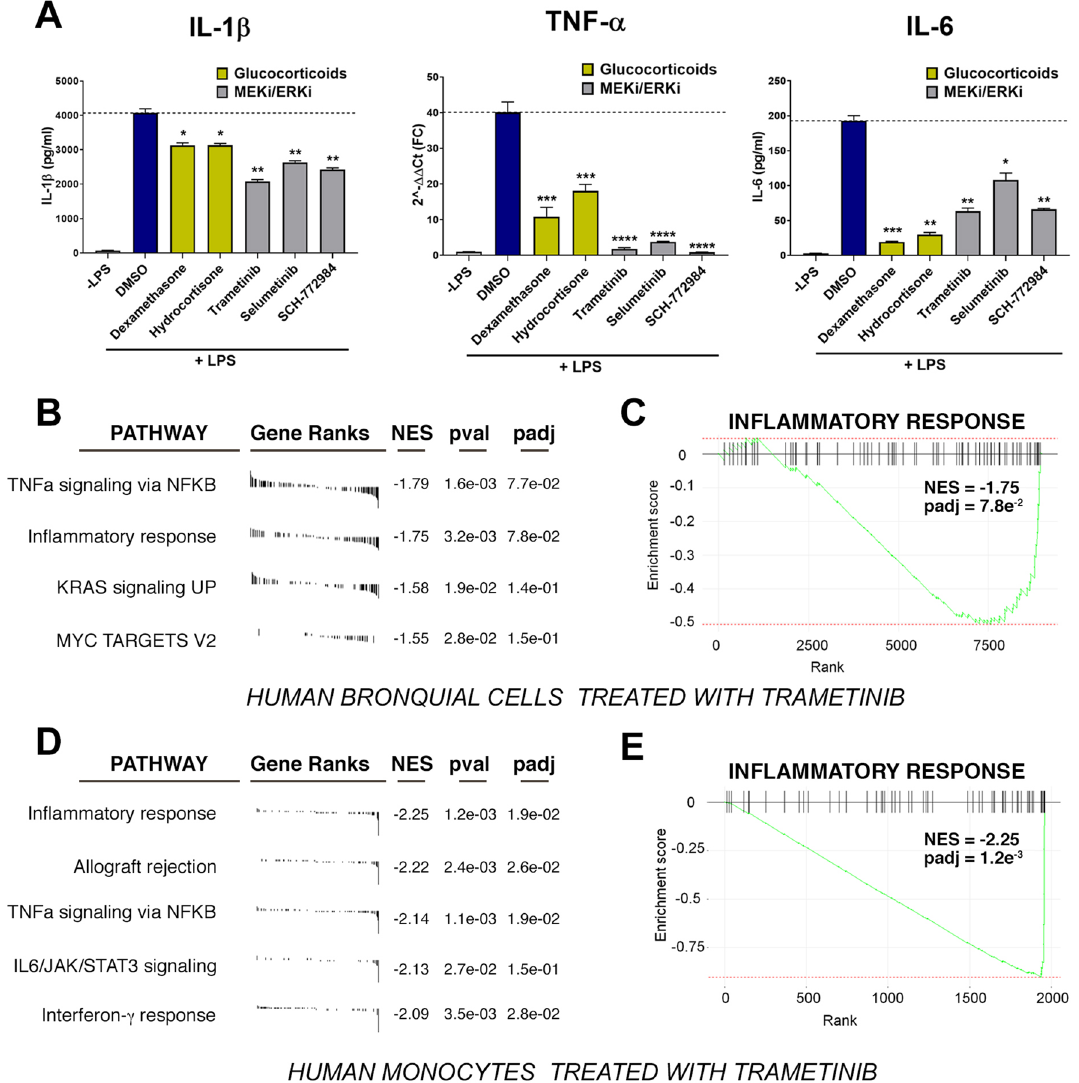
Figure 3. Inhibition of cytokine production by MEK and ERK inhibitors. ( A ) Cytokine expression in macrophages differentiated from THP1 cells upon exposure to LPS, with or without glucocorticoids (dexamethasone and hydrocortisone), MEK inhibitors (trametinib and selumetinib) and an ERK inhibitor (SCH-772984). IL-6 and IL-1β levels were measured by ELISA (pg/ml), and TNF-α by qPCR (2 −ΔΔCt (FC)). The experiment was repeated three times and a representative example is shown. *p < 0.05, **p < 0.01, ***p < 0.001, ****p < 0.0001 ( t test). ( B ) GSEA analysis from human bronquial cells treated with trametinib or DMSO as a control. Differential expression analyses were done from data publicly available at GEO (GSE63229). Pathways names together with their gene ranks, Normalized Enrichment Scores (NES), p-values (pval) and adjusted p-values (padj) are shown. ( C ) Enrichment plot of genes belonging to the “Inflammatory response” pathway resulting from the GSEA analysis mentioned in ( B ) illustrating the inhibition of their expression levels by trametinib in human bronchial cells. ( D ) GSEA analysis from human monocytes treated with trametinib or DMSO as a control. Differential expression analyses were done from data publicly available at GEO (GSE123574). Pathways names together with their gene ranks, Normalized Enrichment Scores (NES), p-values (pval) and adjusted p-values (padj) are shown. ( E ) Enrichment plot of genes belonging to the “Inflammatory response” pathway resulting from the GSEA analysis mentioned in ( D ) illustrating the inhibition of their expression levels by trametinib in human followed by Gene Set Enrichment Analyses (GSEA). Consistent with our THP-1 data, GSEA from human bron- quial cells revealed that the pathways most significantly downregulated in trametinib-treated cells were “TNF-α signaling via NFκB” and “inflammatory response”, together with the expected downregulation of Ras signaling (“KRAS signaling up”) and “MYC targets” (Fig. 3B,C). Likewise, GSEA in human monocytes showed these two pathways, plus “allograft rejection”, “IL6-JAK-STAT3 signaling” and “interferon-γ response” as the ones being most repressed by trametinib (Fig. 3D,E). Collectively, these experiments provide support to the concept of